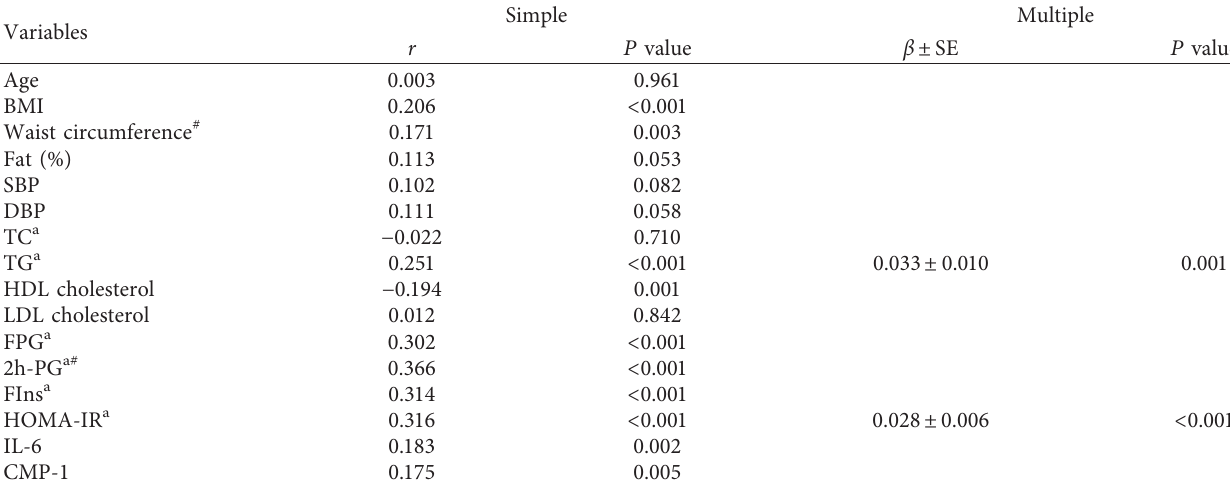
Table 2: Correlation of serum l g (asprosin) levels with clinical variables in all subjects.